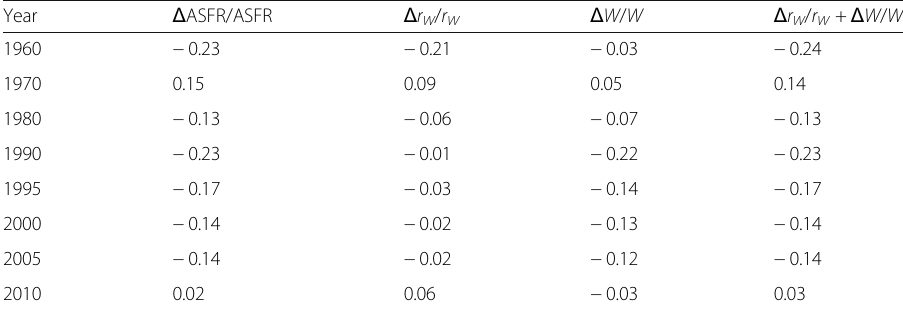
Table 1 Data from the 25 – 29 age group in Japan over the time frame 1950 to